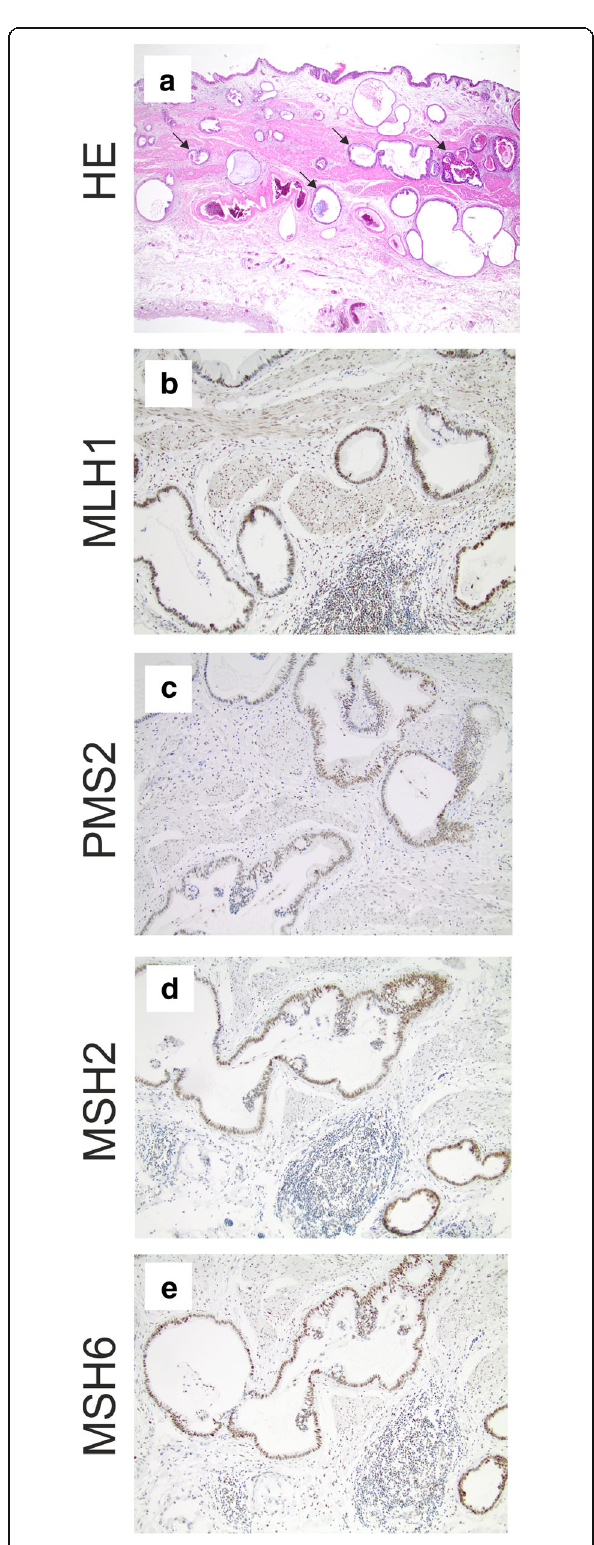
Fig. 2 Histology and immunohistochemistry of the detected MSI gallbladder carcinoma. a : Hematoxylin & Eosin (HE) staining of a full-slide section of the detected MSI GBC shows a typical ductal morphology of pancreatobiliary subtype (representative atypical neoplastic ducts are indicated by arrows, original magnification: 20x). b - e : Immunohistochemistry of MMR proteins showed retained nuclear signals in the neoplastic epithelia (MLH1, PMS2, MSH2,